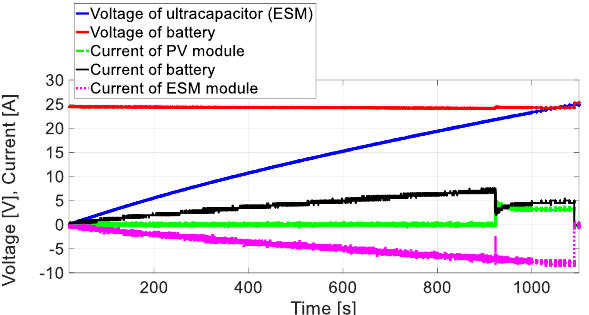
Figure 5. Voltages and currents during ESM charging in standard conditions (ambient temperature 20 °C ). The positive current value means current drawn, the negative is the current delivered.